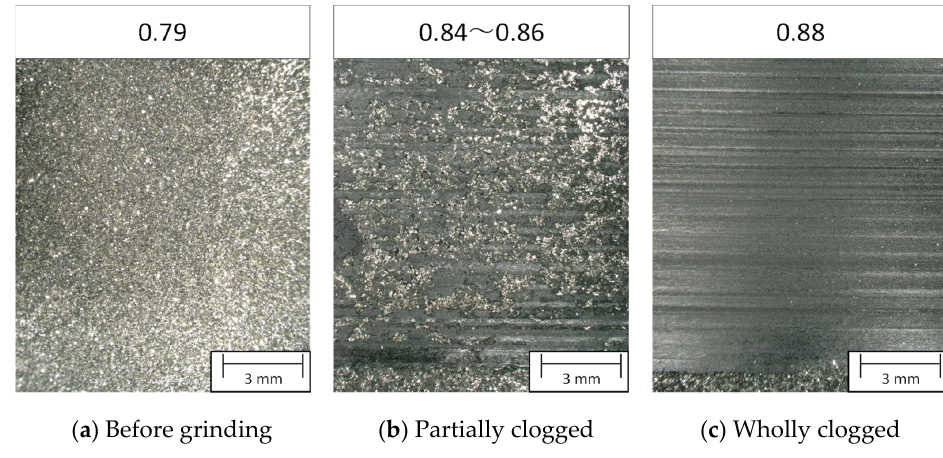
Figure 10. Transition of emissivity of grinding surface.